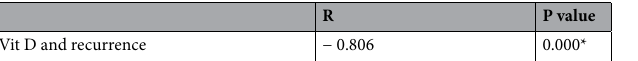
Table 4. Correlation between VIT D and recurrence. * highly significant.